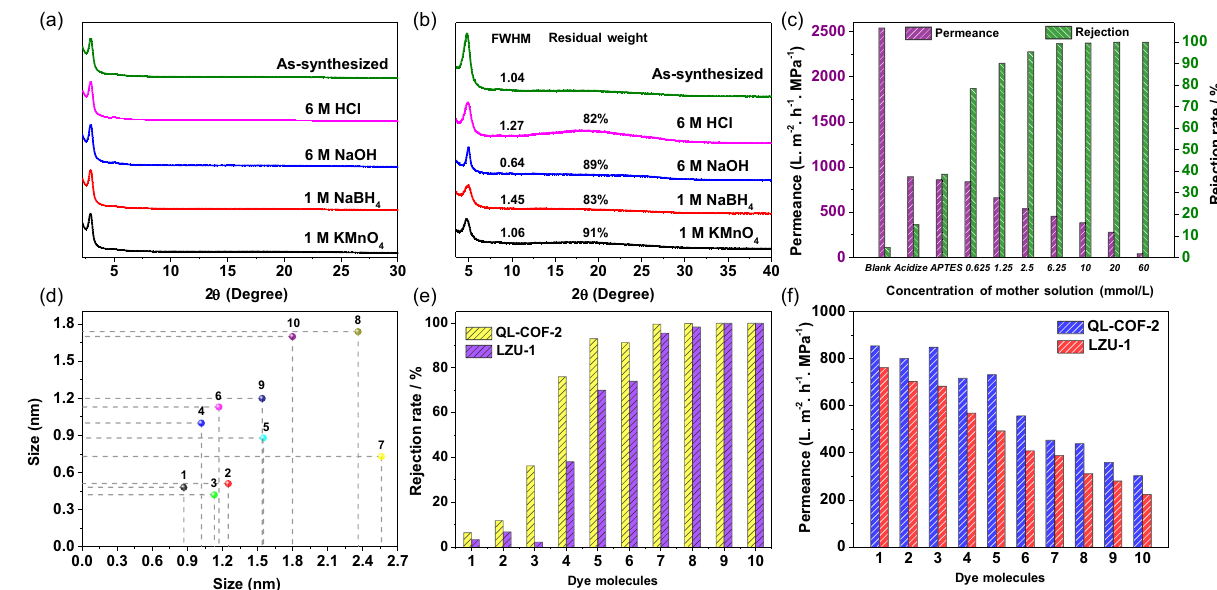
Fig. 3 Stability test of QL-COFs and nano fi ltration performance test of QL-COF-2 membrane. PXRD patterns measured after one day treatment of QL- COF-1 ( a ) and QL-COF-2 ( b ) in 6M HCl (pink), 6M NaOH (blue), 1M NaBH 4 (red) and 1M KMnO 4 (black). c The water permeances and dye rejection rates of blank tube and the QL-COF-2 membranes synthesized at different concentration of the mother solution in the nano fi ltration experiments of 50ppm Congo red. d Serial numbers and molecular sizes of dyes in nano fi ltration experiments. 1-Neutral red, 2-methylene blue, 3-methyl orange, 4-acid blue, 5-chrome black T, 6-acid fuchsin, 7-Congo red, 8-methyl blue, 9-rose bengal, 10-vitamin B-12. e Rejection rates of various dyes through the QL-COF-2 and LZU-1 membranes. f Water permeances of various dyes through the QL-COF-2 and LZU-1